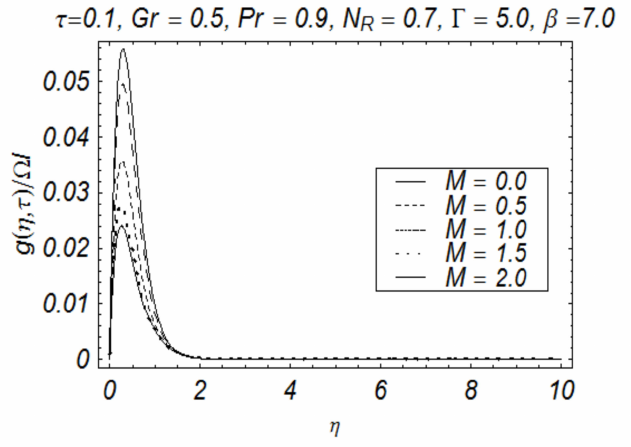
Figure 5. Indication of M on secondary